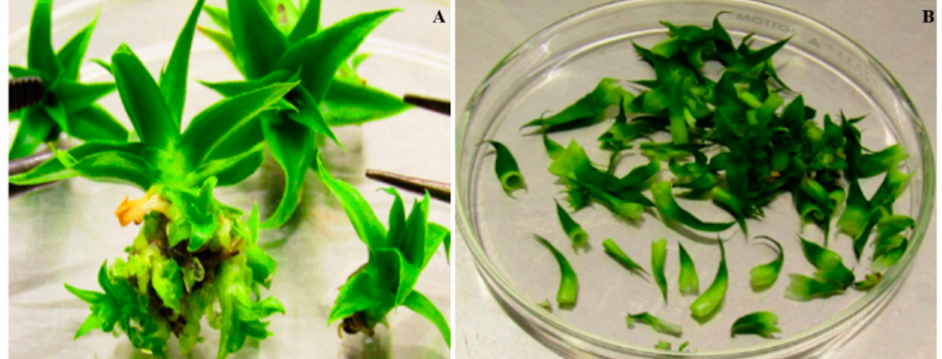
Figure 1. ( A ) Aseptic ‘MD2’ pineapple in vitro plants (4–6 weeks old) used as a source of explants to induce direct and/or indirect morphogenesis; ( B ) leaves isolated from the in vitro plants used as initial